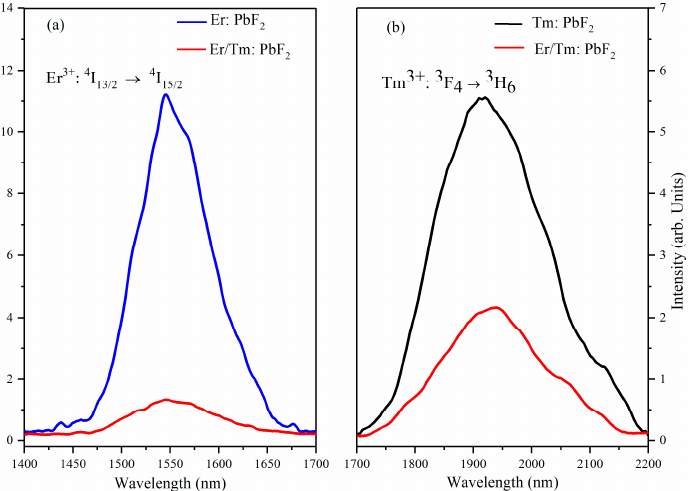
Figure 5. ( a ) Emission spectra of the Er: PbF 2 , Er/Tm: PbF 2 crystals in the range of 1400–1700 nm ( λ ex = 800nm); ( b ) emission spectra of Tm: PbF 2 , Er/Tm: PbF 2 crystals in the range of 1700–2200 nm ( λ ex = 800nm).